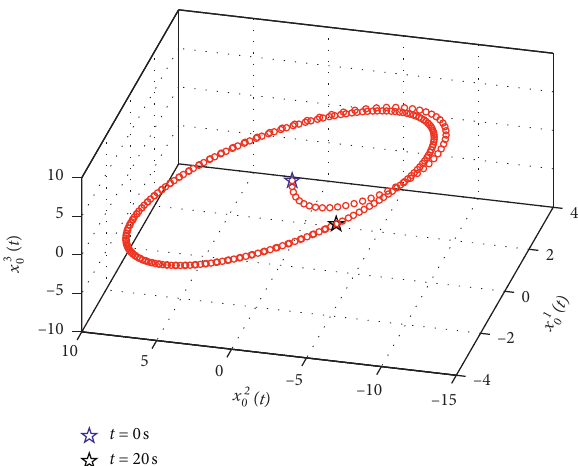
Figure 4: Movement track of the leader for time-varying formation tracking case.